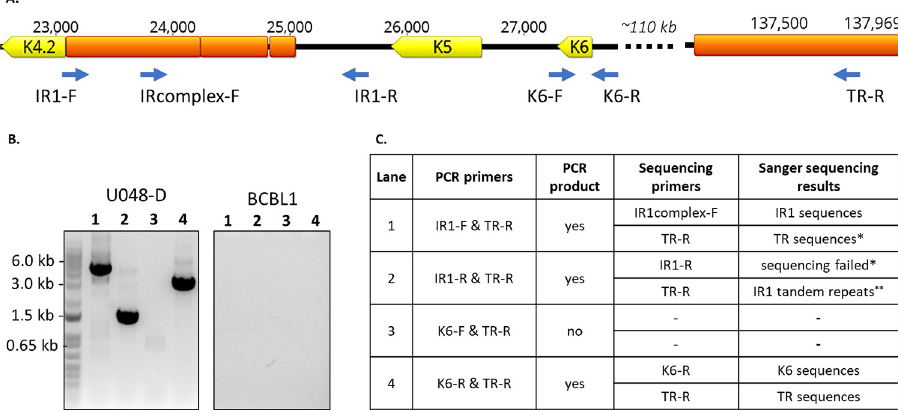
Fig 2. Confirmation of breakpoints connecting IR1 and K6 to TR sequences in tumor U048-D. A. The region of the KSHV genome from K4.2 through K6 and a distant TR unit sequence is shown. ORFs are shown in yellow, repetitive sequences in orange, and primers with blue arrows. B. PCR products were separated on a 0.8% agarose gel, and visible bands were extracted and sequenced using the Sanger method. DNA from the BCBL1 cell line was used as control, and no visible PCR products were produced. (PCR products from primer pairs IR1-F & IR1-R and K6-F & K6-R are shown in S1 Fig). C . Summary of results. � = Primarily due to ambiguous and low quality base calls. �� = Result truncated at